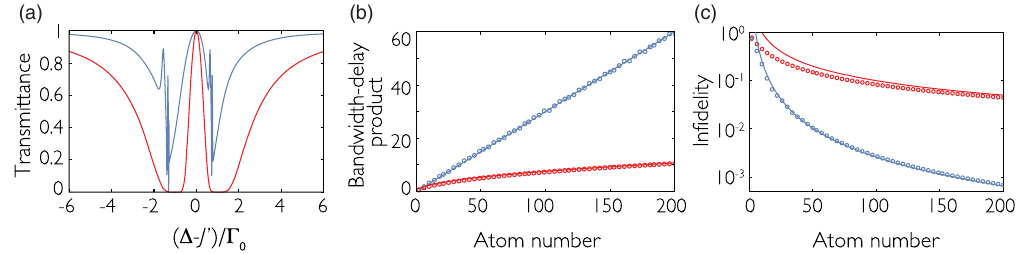
FIG. 14. Electromagnetically induced transparency and photon storage efficiency, within the independent emission (red) and collective emission (blue) models. (a) Transmittance spectrum for a chain of N ¼ 20 atoms. The control field Rabi frequency is set to Ω Γ 0 , while other system parameters can be found in the main text. (b) Scaling of the bandwidth-delay product with the number of c ¼ atoms N . The circles represent the numerical calculation. The red line shows the theoretically predicted answer within the independent ffiffiffiffi ffiffiffiffi p p ≃ 0 . 76 D N emission model, P ¼ , and the blue curve represents the best fit of the numerical data to a linear scaling, P ≃ 0 . 30 N . The control field intensity is the same as in (a). (c) Infidelity in the retrieval of the spin excitation given by Eq. (26). The circles show the numerics. The red line represents the expected scaling derived in Ref. [38], within the independent emission model, ε ¼ 5 . 8 =D ≃ 10 =N , and the blue line is the best fit of the numerical results to a ∝ N − 2 scaling, and shows ε ≃ 26 =N 2 (the range for the fit is N ∈ ½ 30 ; 200 (cid:3)